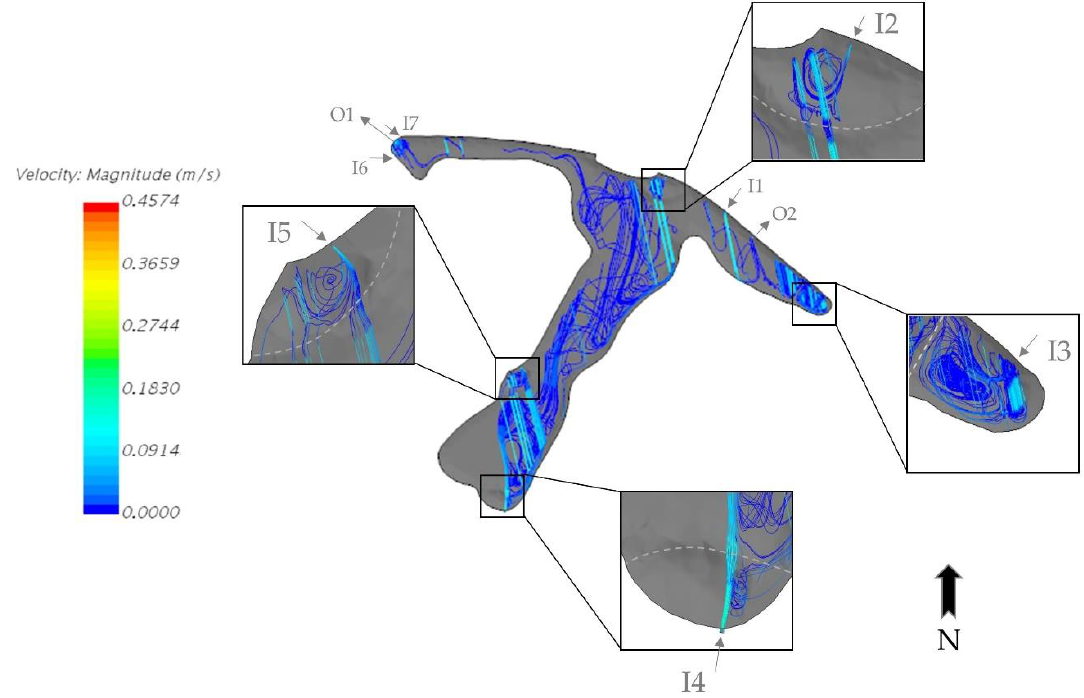
Figure 9. Velocity streamlines on 26 August 2007 at 3 p.m. (during the storm).